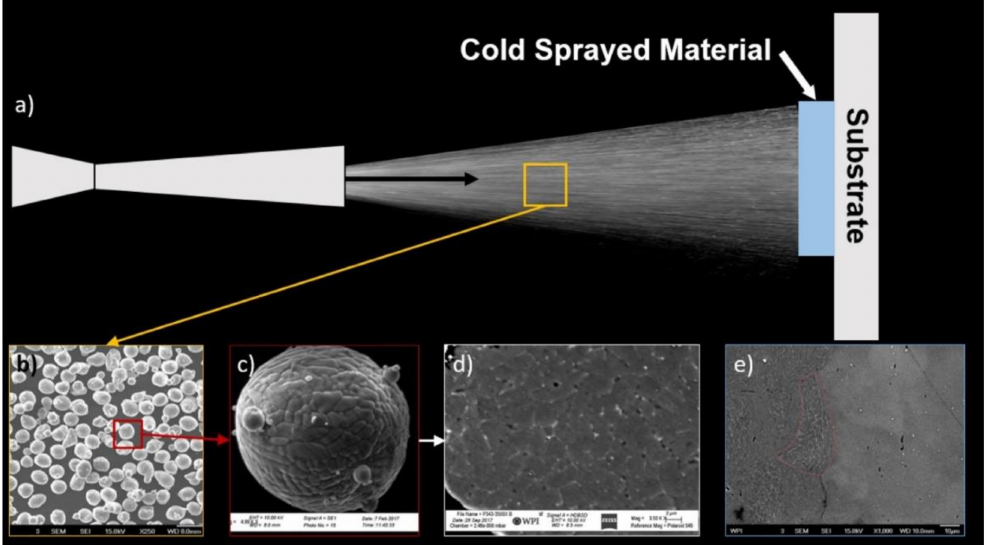
Figure 1. Schematic of the cold spray process, from powder to coated